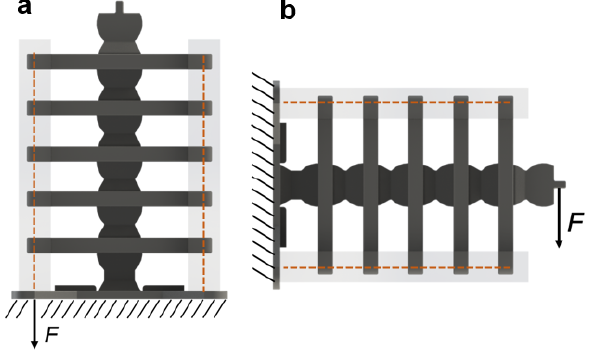
Figure 9. Loading configurations in the ( a ) vertical and ( b ) horizontal directions. F is the applied load. The orange dash lines indicate the internal fibers The metal base of the musculoskeletal system was rigidly fixed to a test frame with four bolts. The test was constructed with 80/20 T-slot aluminum, as shown in Figure 10. The musculoskeletal system bending motion was recorded using a video camera (Model: HDR-CX405, SONY, Tokyo, Japan). The recording was set for a full high-definition option with 60 frames/second. Both the musculoskeletal system and camera were rigidly secured to the test frame to maintain accurate measurements.